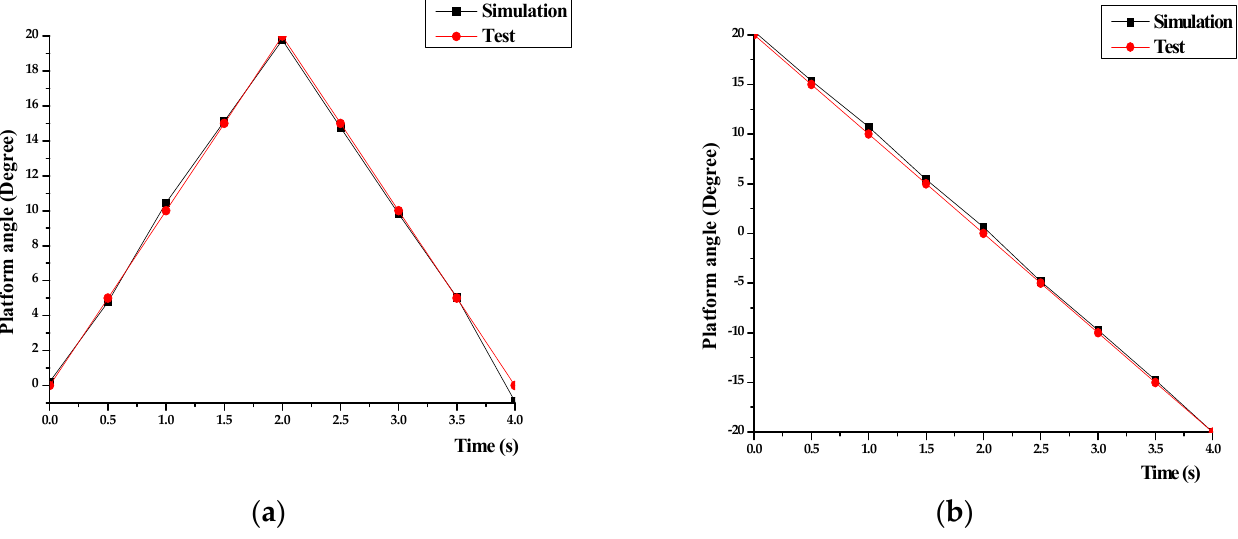
Figure 31. Comparison of the trajectory error ( a ) roll ( b ) pitch.